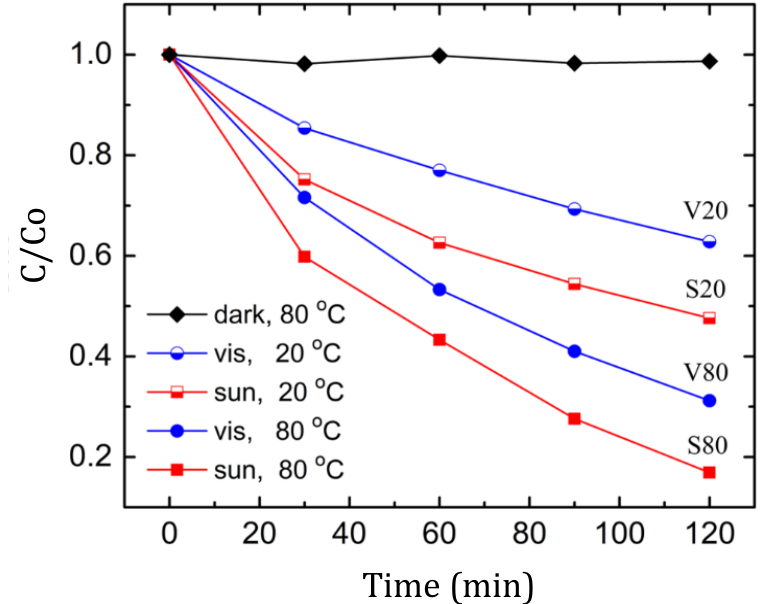
Figure 4. Temporal changes in the normalized absorbance of MB solution (10 mg·L −1 ) in the dark at 80 °C (black symbols) and under illumination with visible (V) light and sunlight (S) at 20 and 80 °C.